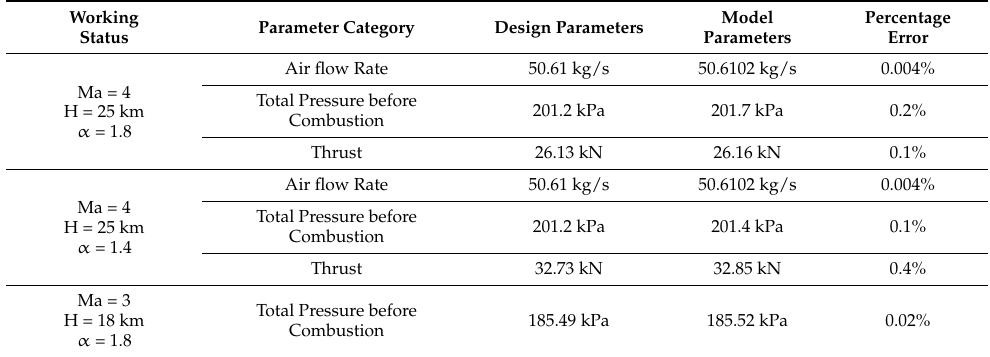
Table 1. Engine parameters verification.